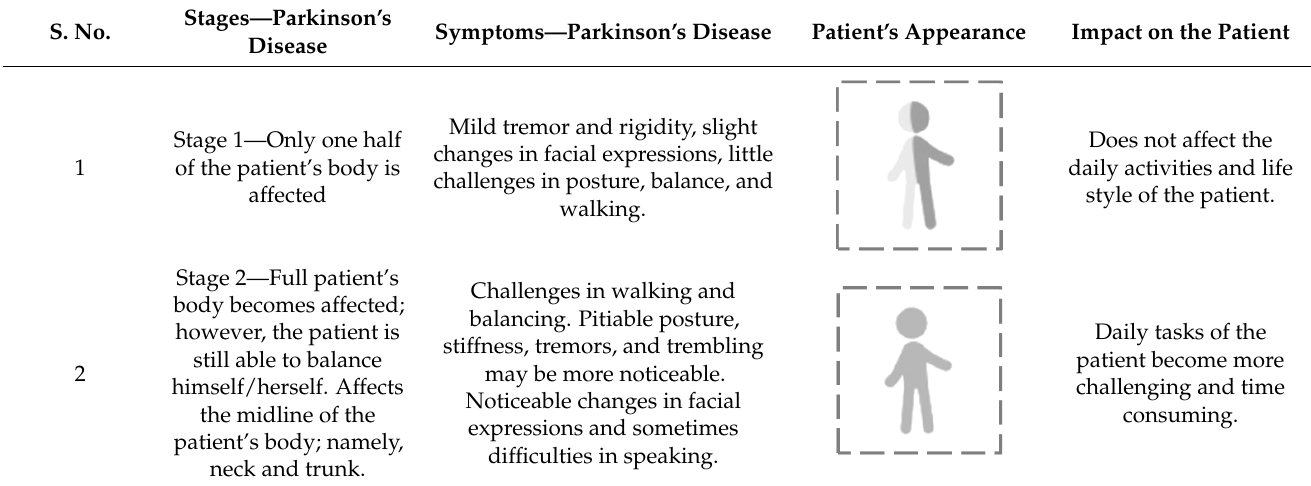
Table 3. Various Stages and Symptoms of Parkinson’s Disease.